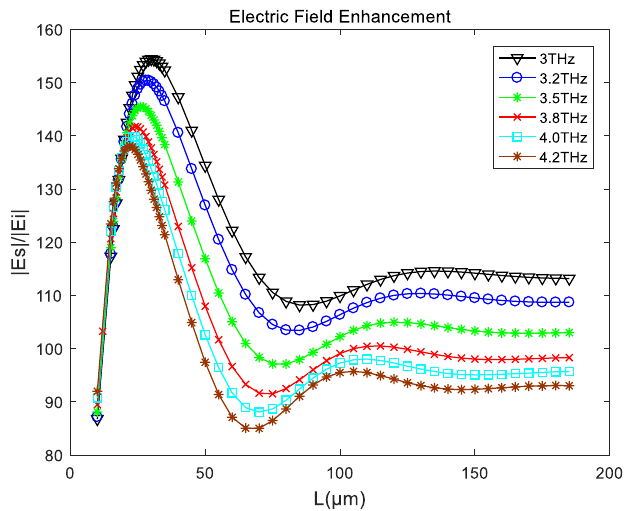
Figure 10. Simulation results of electric field enhancement effect of changing tip length at different frequencies.